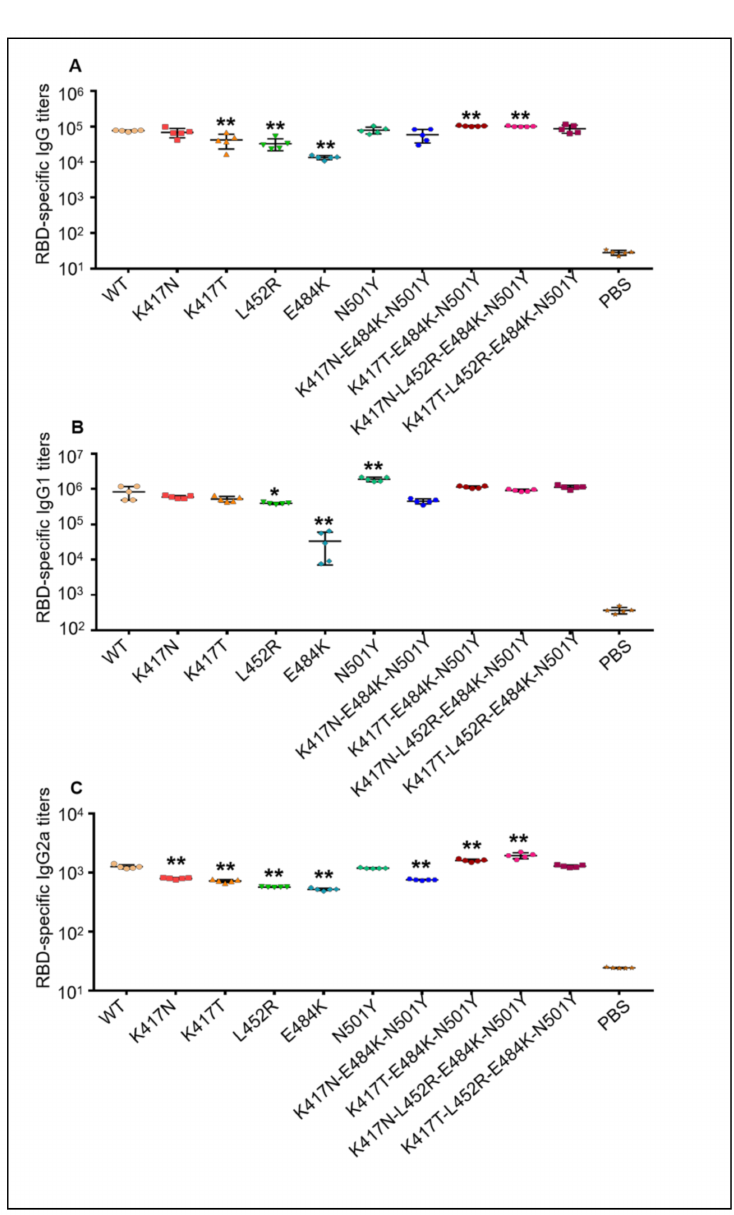
Figure 3. Mutant RBD-Fc proteins of SARS-CoV-2 elicited robust antibody responses in mice. BALB/c mice were immunized with wild-type RBD-Fc protein first and then boosted twice with the indicated mutant RBD-Fc proteins later. Seven days after the final vaccination, the mice sera were collected and subjected to a series of dilutions, followed by the detection of antibodies binding to the wild-type RBD protein without the Fc fragment of human IgG in ELISA. The A450 value in the experimental well containing sera (A450 Exp ) was subtracted at the A450 value in the negative control well without sera (A450 Neg ). Then, the calibrated A450 Exp value and dilution times of the sera in each experimental well were used to generate the standard curve using GraphPad Prism 9. The highest dilution time of sera while the A450 Exp /A450 Neg ≥ 4 was calculated and determined was the RBD protein-specific antibody titer in the immunized mice. ( A ) RBD-specific IgG antibody titers in each immunized mouse; ( B ) RBD-specific IgG1 antibody titers in each immunized mouse; ( C ) RBD-specific IgG2a antibody titers in each immunized mouse. The antibody titers were expressed as mean ± SD of five mice in each group. * ( p < 0.05) and ** ( p < 0.01) mean significant differences between the mutant RBD-Fc protein booster group and wild-type RBD-Fc protein vaccination group. WT: the mice group immunized three times with wild-type RBD-Fc protein; PBS: negative control group injected with PBS plus